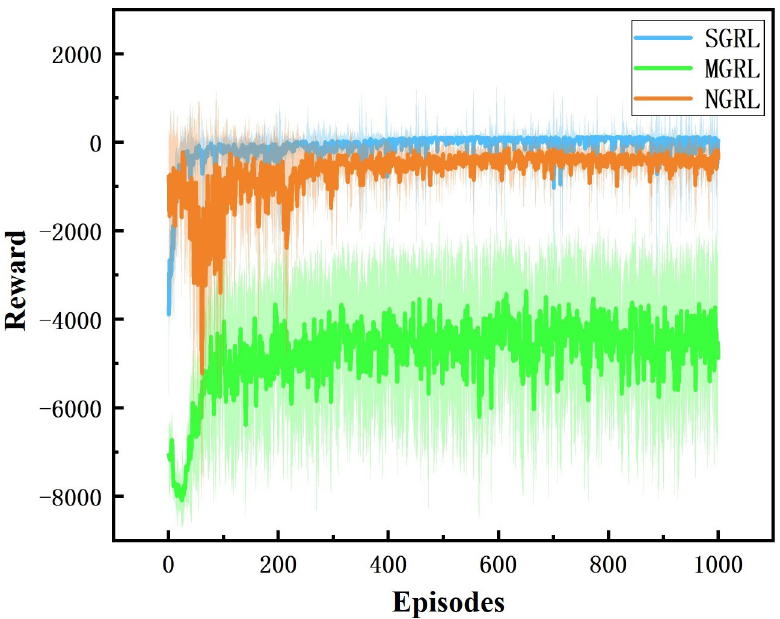
Figure 11. Diagram of reward. This value is the accumulation of each single step reward value.